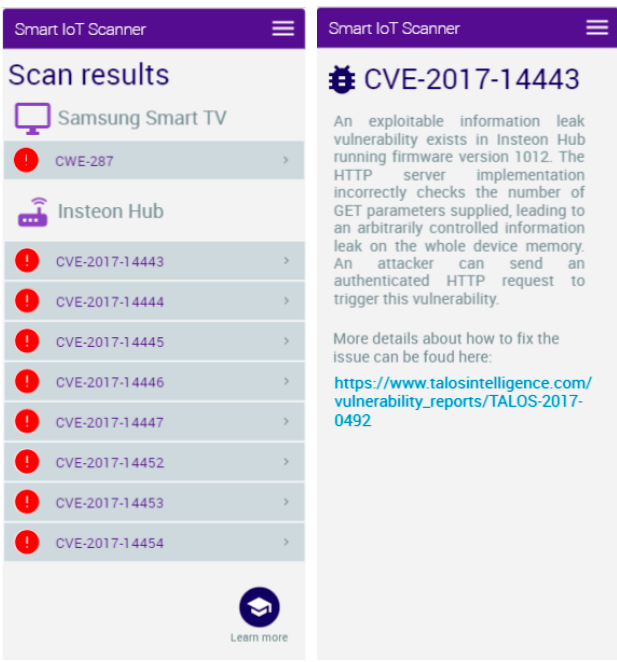
Figure 9. Example of results obtained by the smart scanning app in a smart home environment.